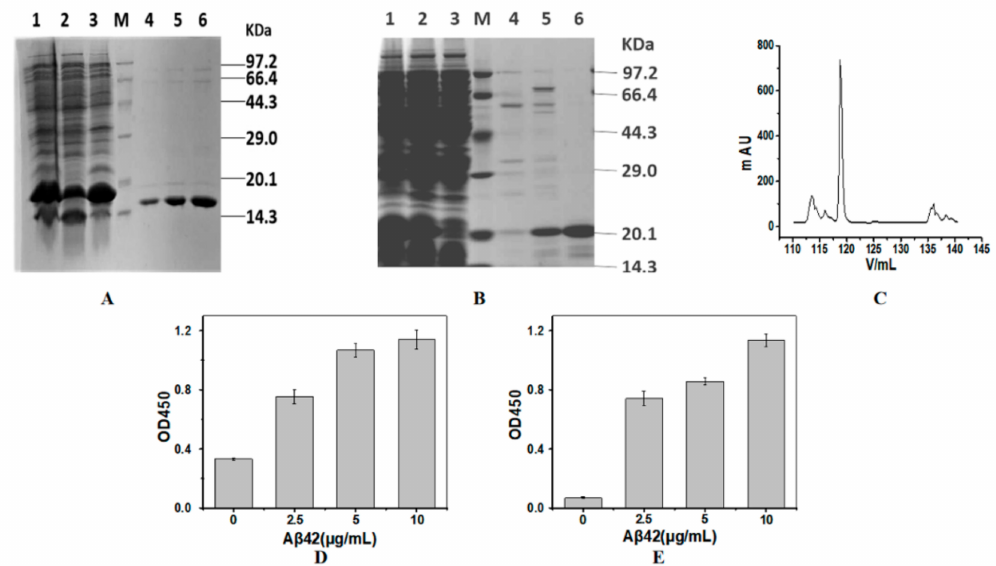
Figure 1. Preparation of the nanobodies. SDS-PAGE analysis of purified SDP6 ( A ) and SH2 ( B , C ) by Ni-NTA a ffi nity chromatography ( A , B ) and gel chromatography ( C ). Activities of SDP6 ( D ) and SH2 ( E ) were detected by ELISA. Lane M, protein molecular weight marker; Lane 1, Total proteins expressed by E.coli ; Lane 2, precipitated proteins after the cells were disrupted and centrifuged; Lane 3, supernatant proteins after the cells were disrupted and centrifuged; Lanes 4–6 of SDP6 were SDP6 nanobody eluted by 60 mM imidazole; Lanes 4 and 5 were SH2 nanobody eluted by 100 mM imidazole; Lane 6 of SH2 was SH2 nanobody after gel